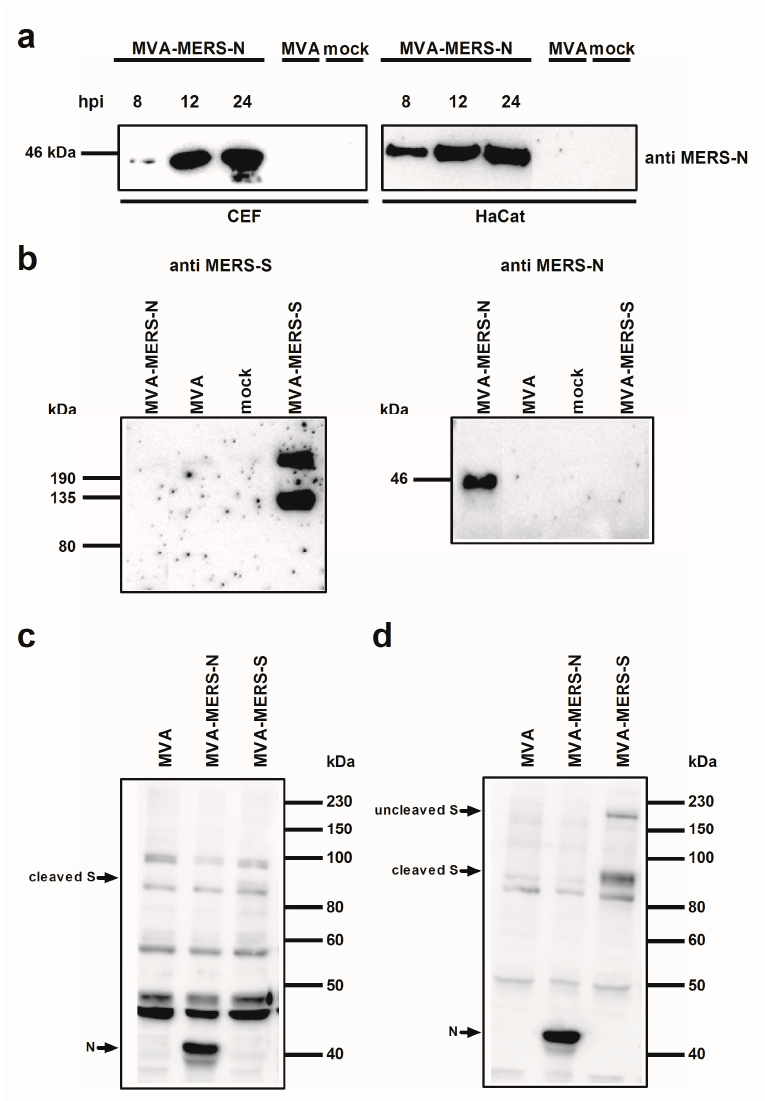
Figure 2. Analysis of recombinant MVA-MERS proteins; ( a ) Western Blot analysis of MERS-CoV N protein produced in CEF or HaCat cells. Lysates from cells infected with recombinant MVA (MVA-MERS-N, MVA-MERS-S) or non-recombinant MVA (MVA) at a MOI of five, or from non-infected cells (mock) were prepared at eight, 12, or 24 hpi. Proteins were analyzed by immunoblotting with a monoclonal anti-MERS-N antibody; ( b – d ) Western Blot analysis of MERS-CoV N and S proteins produced in CEF. Total cell extracts from CEF infected with recombinant MVA (MVA-MERS-N, MVA-MERS-S) or non-recombinant MVA (MVA) at a MOI of five, or from non-infected cells (mock) were prepared at 24 hpi. Cell lysates and proteins were tested by immunoblotting using monoclonal anti MERS-N and anti MERS-S antibody ( b ) or polyclonal sera from MERS-CoV infected rabbits ( c ) or cynomolgus macaques ( d ). Arrows indicate the N- or S-specific protein